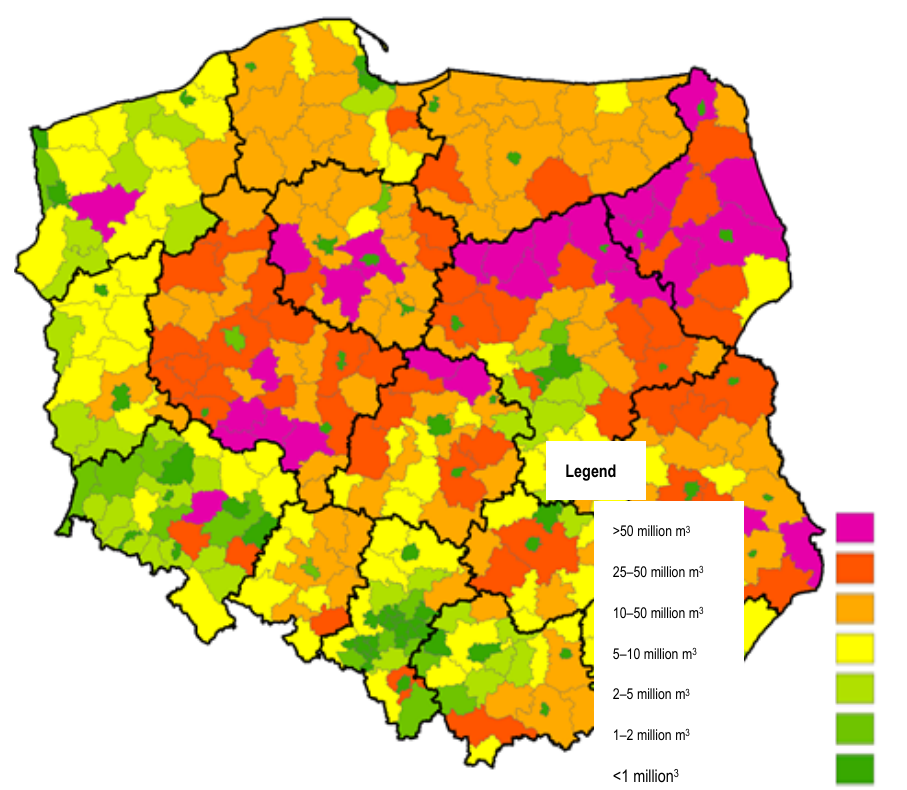
Figure 1. The potential of biogas production in Poland for poviats; source: [74].